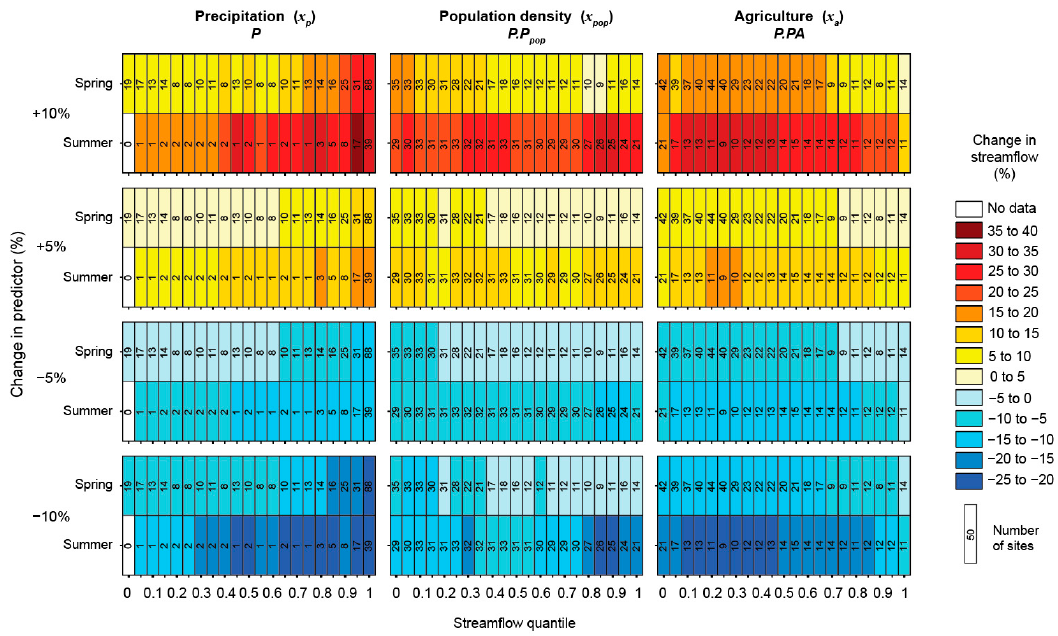
Figure 10. Sensitivity analyses for three models based on a change in each predictor (precipitation, population density or agriculture) within three models: P , P . Ppop and P . PA . The four panels indicate a change in each predictor of +10%, +5%, − 5% and − 10%, from top to bottom. Within each panel, spring and summer seasons are shown (top and bottom, respectively). All streamflow quantiles are shown (x-axis). The percent change in streamflow resulting from a given change in each of the predictors is indicated in colors ranging from dark blue (strong decrease in streamflow) to dark red (strong increase in streamflow).